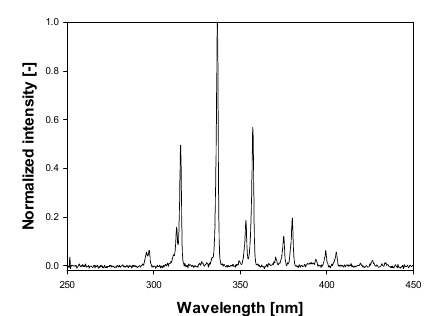
Figure 1. Spectral data processing to minimize the effect of noise.